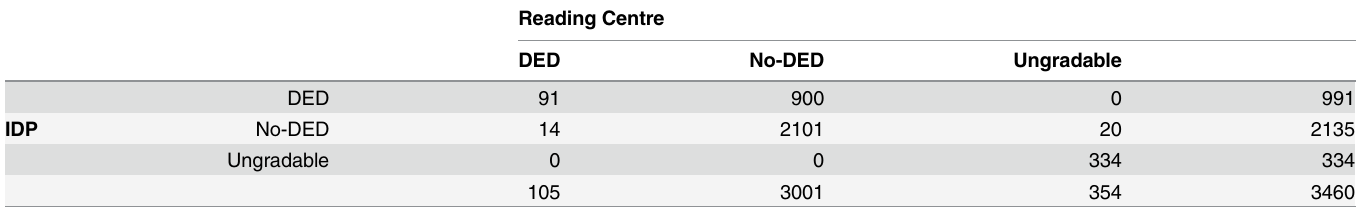
Table 3. Results — Comparison of the grading of DED from the IDP and the Reading Centre – After review grading by retinal